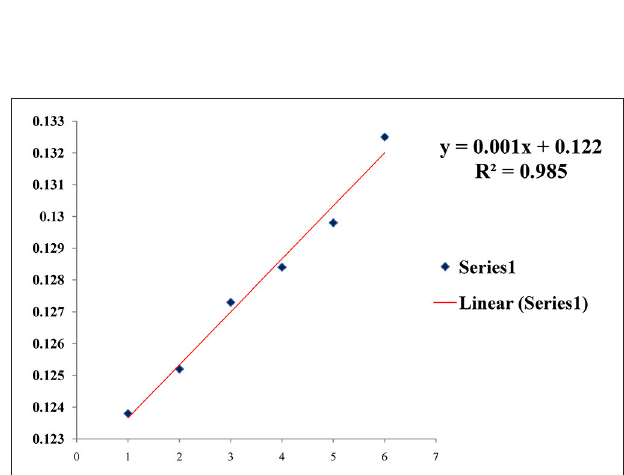
FIGURE 5 | A linear correlation in presence of various concentration of